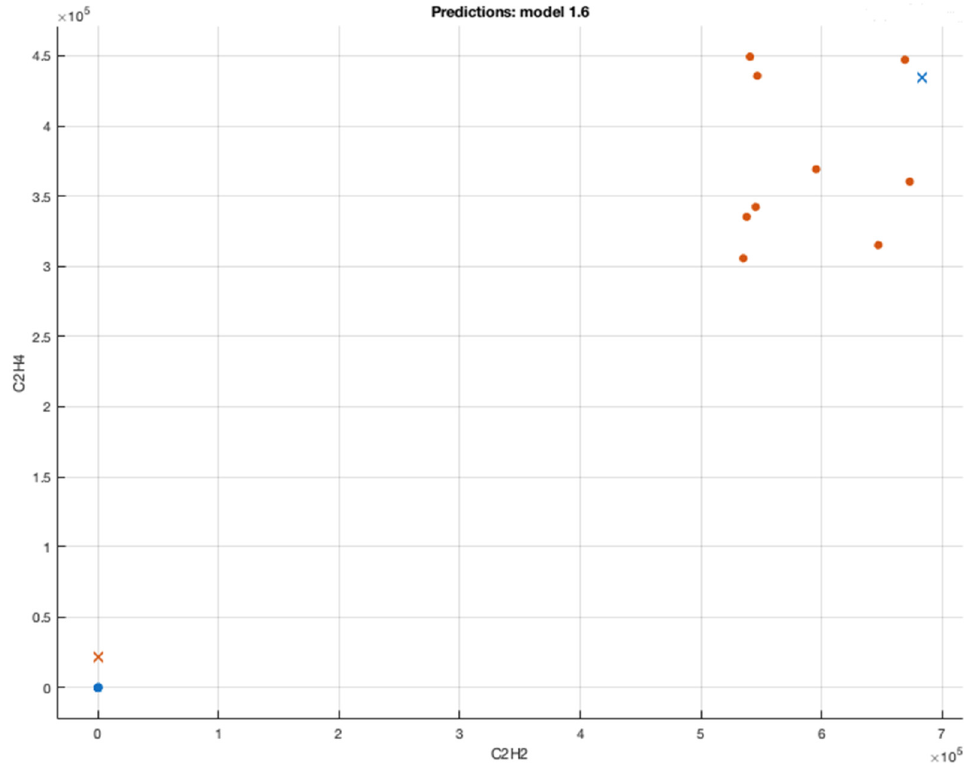
Figure 12. C 2 H 2 versus C 2 H 4 . Blue and orange ( • )—raw data, orange and blue ( × )—predicted Figure 12. C (cid:2870) H (cid:2870) versus C (cid:2870) H (cid:2872) . Blue and orange (•)—raw data, orange and blue (×)—predicted data.